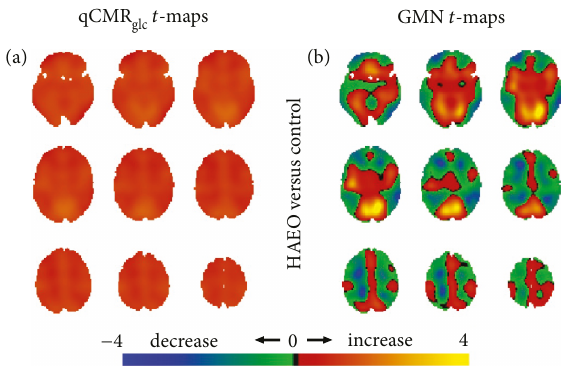
images and (b) glc indicated the presence of globally unidirectional glc to aCMR -HYD (Figures 1 and 2; Table 2), without GMN the global glc glc